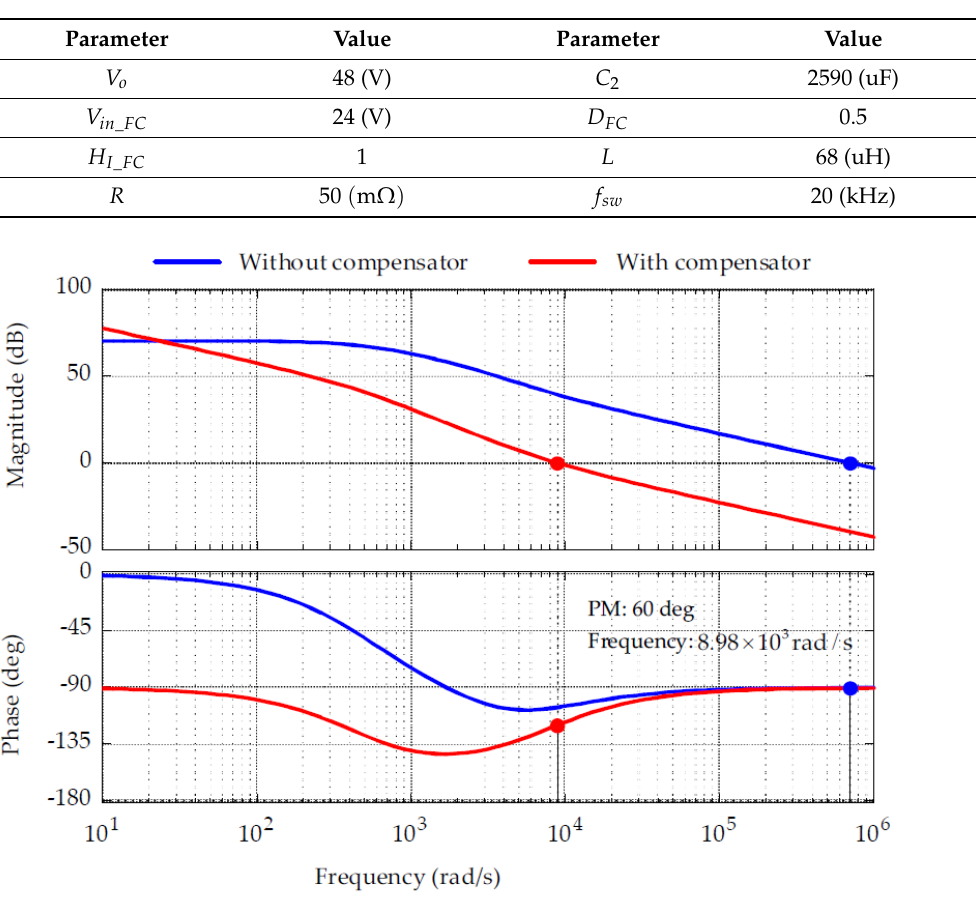
Table 7. Parameters of the PEMFC converter.